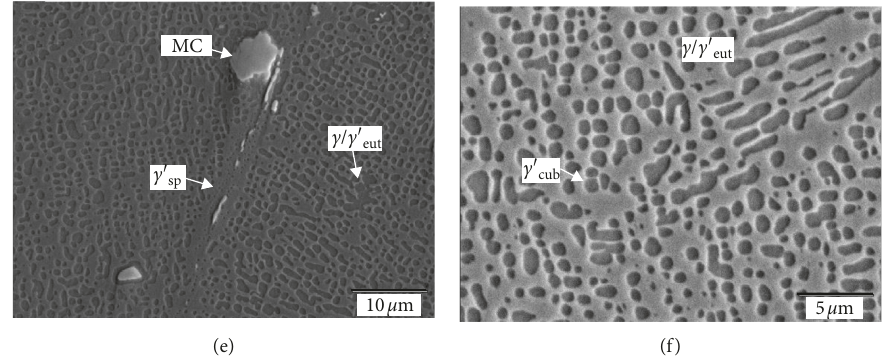
Figure 12: SEM micrographs of the reheat treatment blade for the conditions: (a–c) solution treating and (d–f) complete heat